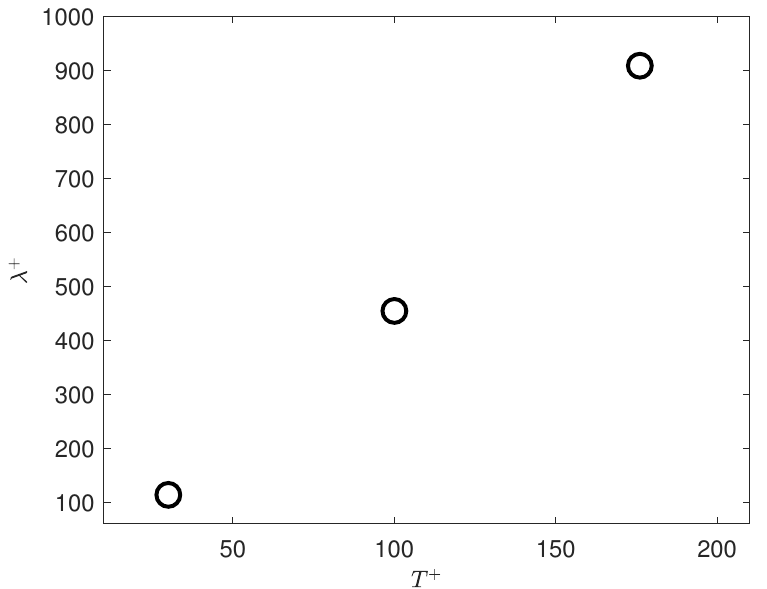
Figure 7. Wavelength of progression wave as a function of forcing period.